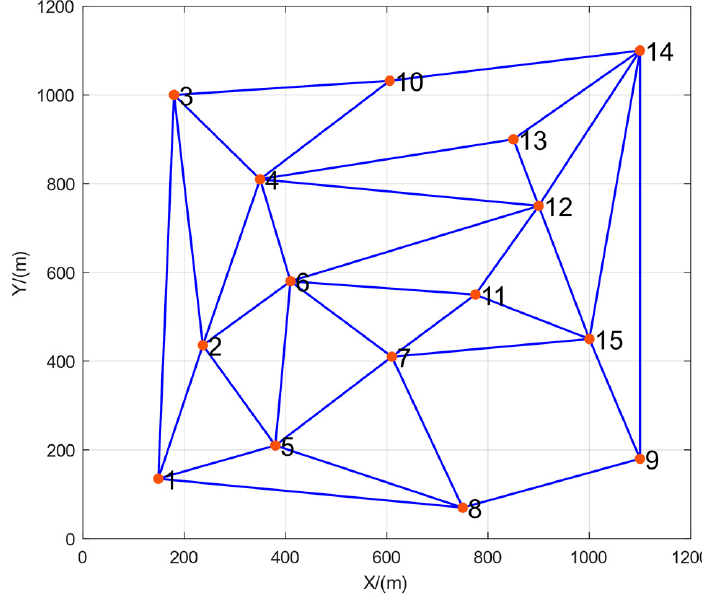
Figure 9. Incomplete environment including 15 task nodes. Table 5. Expected period of 15 task nodes.